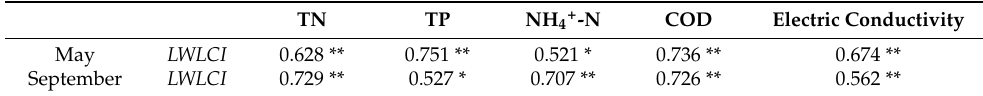
Table 7. Correlation between the LWLCI and water quality